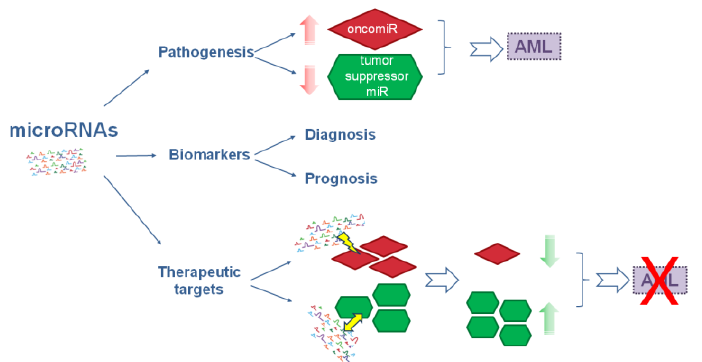
Figure 1. Schematic diagram of microRNAs role in AML. MicroRNAs are involved in pathogenesis and are considered as biomarkers and therapeutic targets in AML. Red arrows indicate overexpression of oncomiR and downexpression of tumor suppressor miR which cause AML; lightning and two-headed arrow indicate targeting and restore, respectively; green arrows indicate decreased oncomiR or increased tumor suppressor miR levels that block AML; red cross indicates AML block.